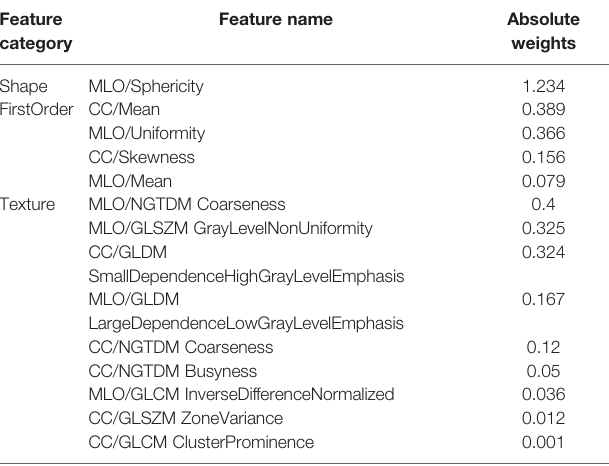
TABLE 2 | Absolute value of weights of selected useful radiomics features in training